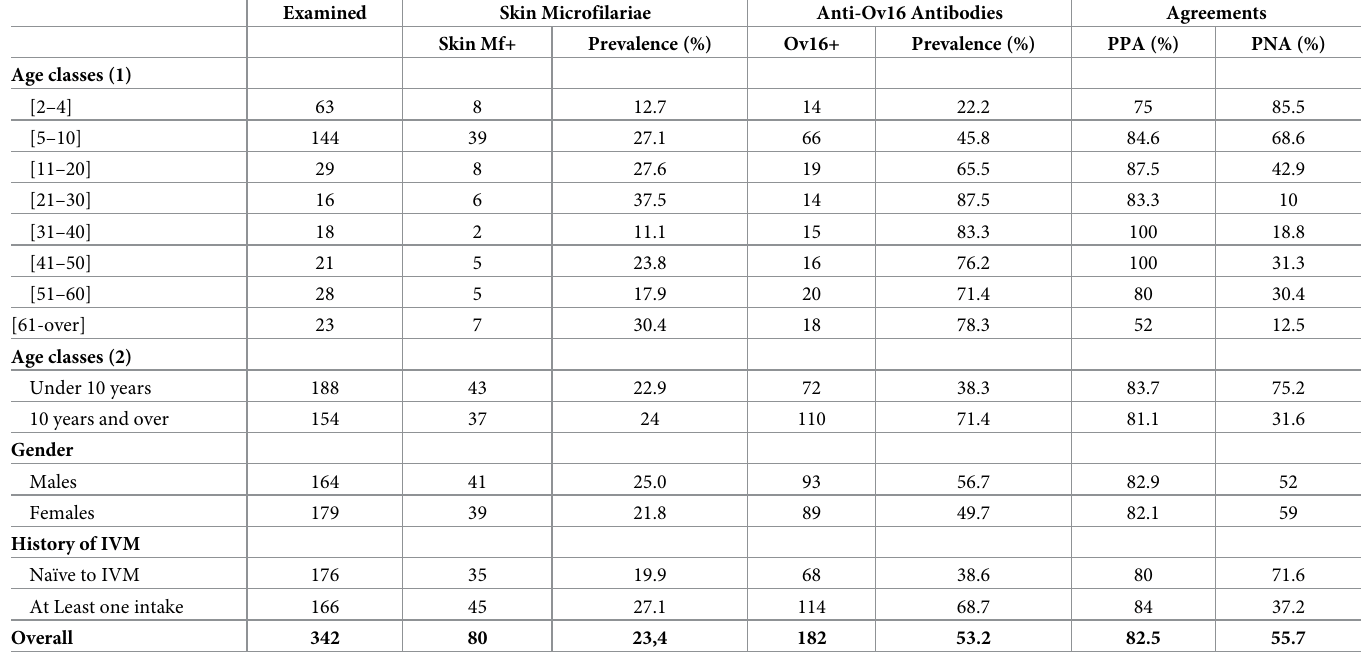
Table 2. Onchocerciasis microfilaridermia and anti-Ov16 IgG4 prevalences, and agreement between skin snip and SD Ov16 ELISA according to age, gender and IVM